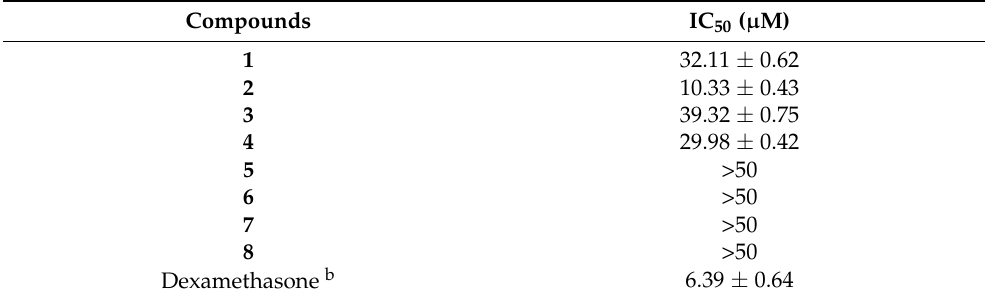
Table 2. Anti-inflammatory effects of compounds 1–8 on the production of the NO in LPS-stimulated RAW264.7 Cells a